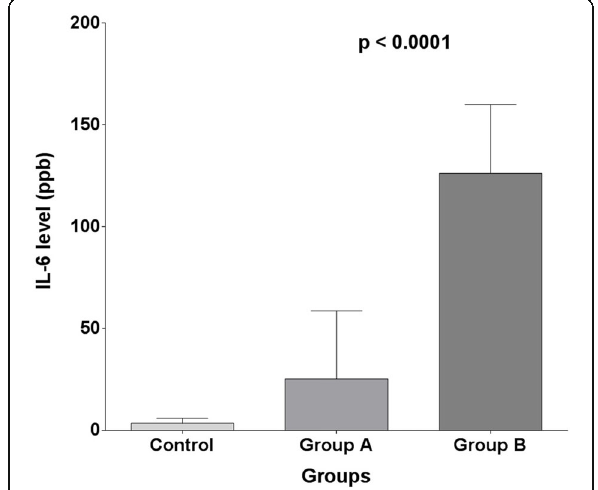
Fig. 1 One-way ANOVA test for IL-6 groups